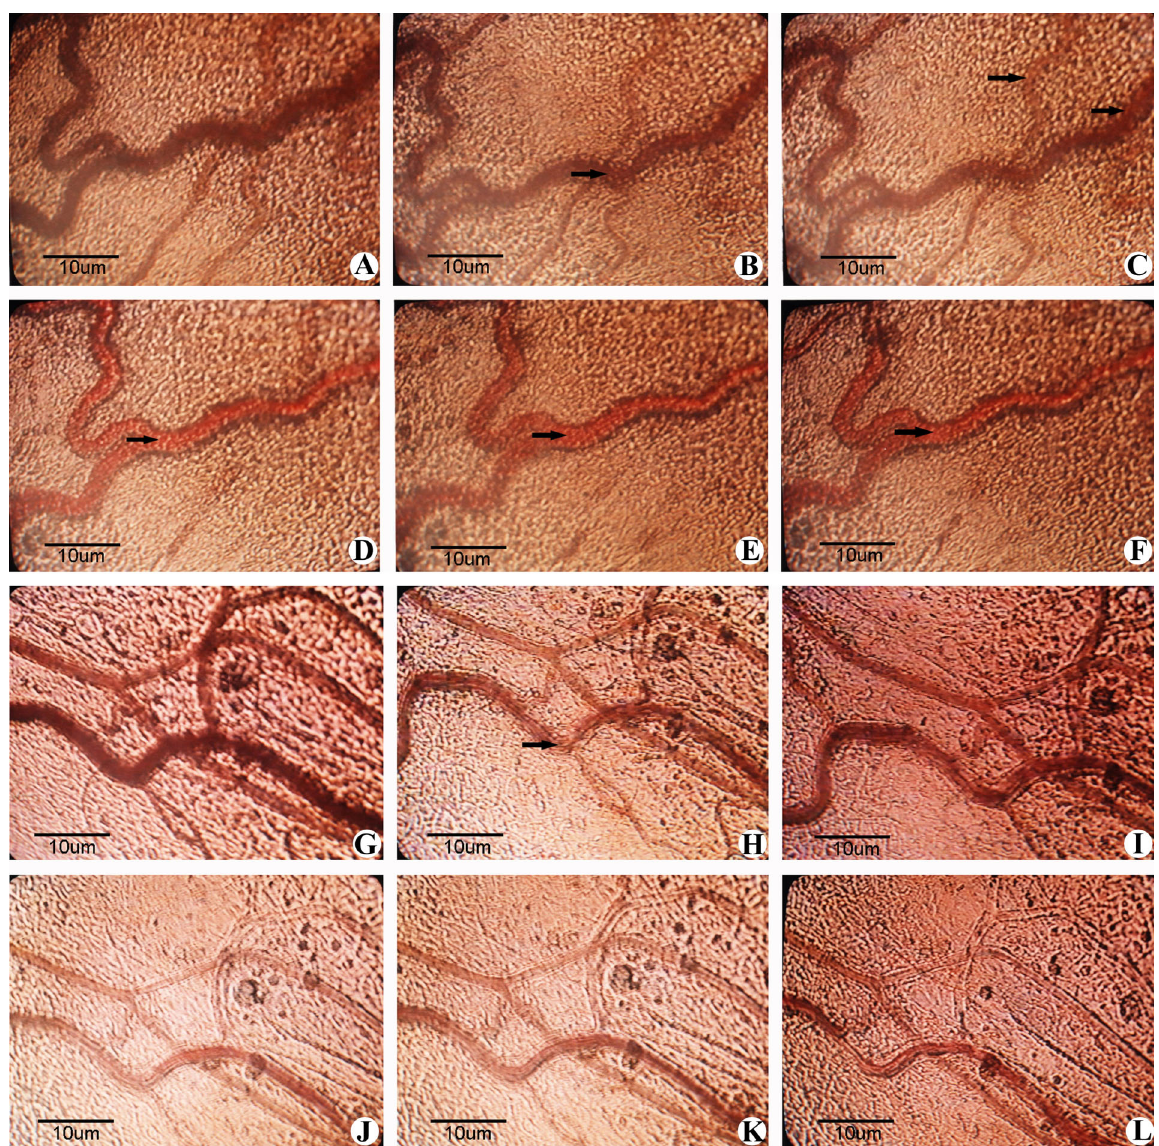
Figure 2. Vital micrograph of the microcirculation in the DIC + saline and DIC + lymph groups. A , Before administration of Dextran 500 to the DIC + saline group; B , 5 min after administration of Dextran 500 to the DIC + saline group, the blood stream showed granular or slow granular flow (arrow); C , 10 min after administration of Dextran 500 to the DIC + saline group, the blood stream showed granular or slow granular flow (arrows); D , 20 min after administration of Dextran 500 to the DIC + saline group, the blood stream showed vibratory granular flow and moderate erythrocyte aggregation (arrow); E , 30 min after administration of Dextran 500 to the DIC + saline group, the blood stream showed vibratory granular flow and moderate erythrocyte aggregation (arrow); F , 40 min after administration of Dextran 500 to the DIC + saline group, the blood stream showed vibratory granular flow and moderate erythrocyte aggregation (arrow); G , before administration of Dextran 500 to the DIC + lymph group; H , 5 min after administration of Dextran 500 to the DIC + lymph group, the blood stream showed granular or slow granular flow (arrow); I , 10 min after administration of Dextran 500 to the DIC + lymph group; J , 20 min after administration of Dextran 500 to the DIC + lymph group; K , 30 min after administration of Dextran 500 to the DIC + lymph group; L , 40 min after administration of Dextran 500 to the DIC + lymph